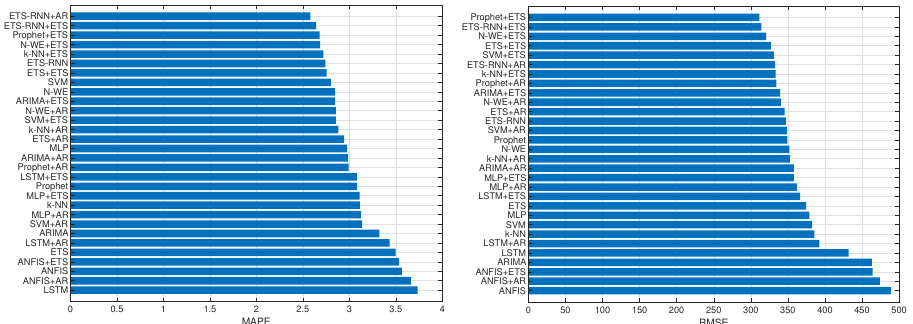
Figure 13. Errors of the models.